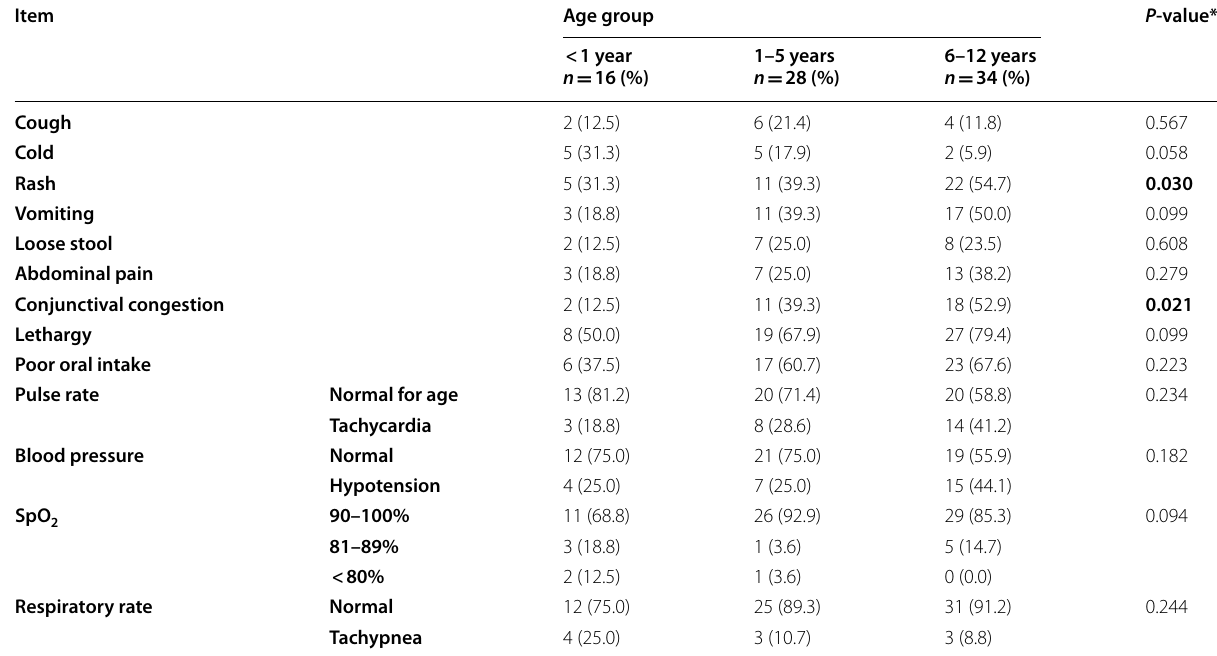
Table 1 Comparison of clinical symptoms and sign with demographic